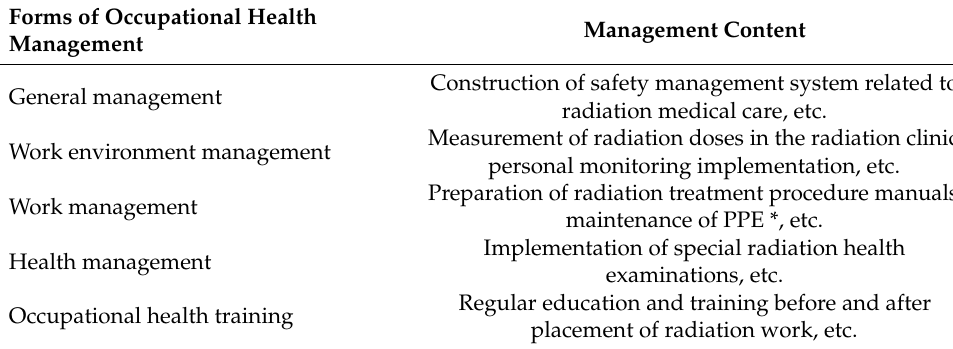
Table 1. Occupational health management in radiation medical